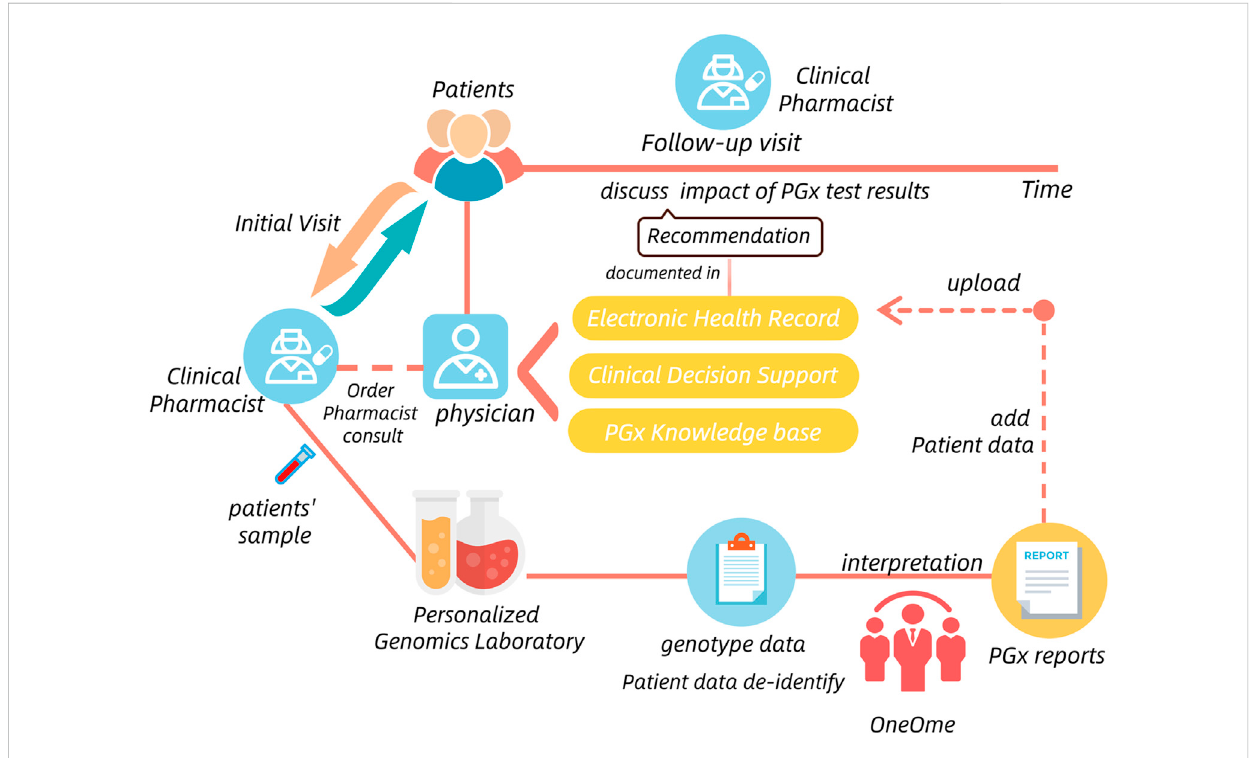
FIGURE 6 The process and involved departments of PGx Testing in the Mayo